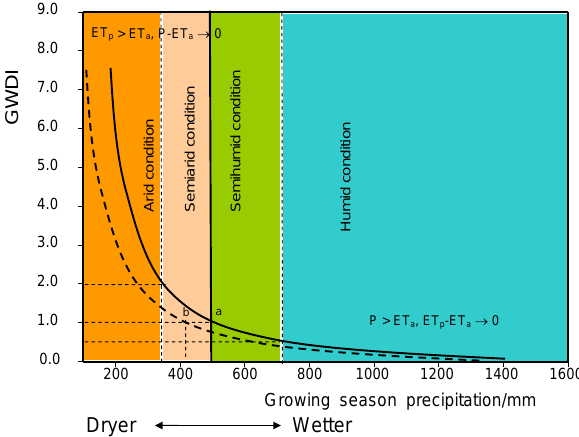
Fig. 2. The growing season water deficit (GWDI) response curve to precipitation. The vertical solid line represents the hydrological balance precipitation that corresponds to GWDI = 1, the same con- dition with aridity index (AI)=1 (assuming P =ET 0 ). The semiarid and semihumid conditions correspond to the “equitant” condition defined by McVicar et al. (2012b). The left-shifted (a → b) balance line (dash-line curve) represents the potential influences of soil wa- ter storage change to